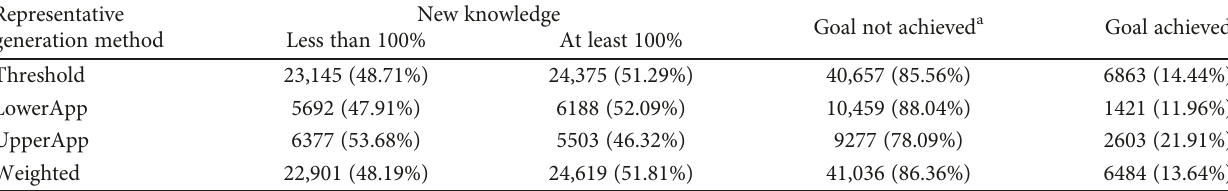
Table 2: Inference e ffi ciency vs. representative generation